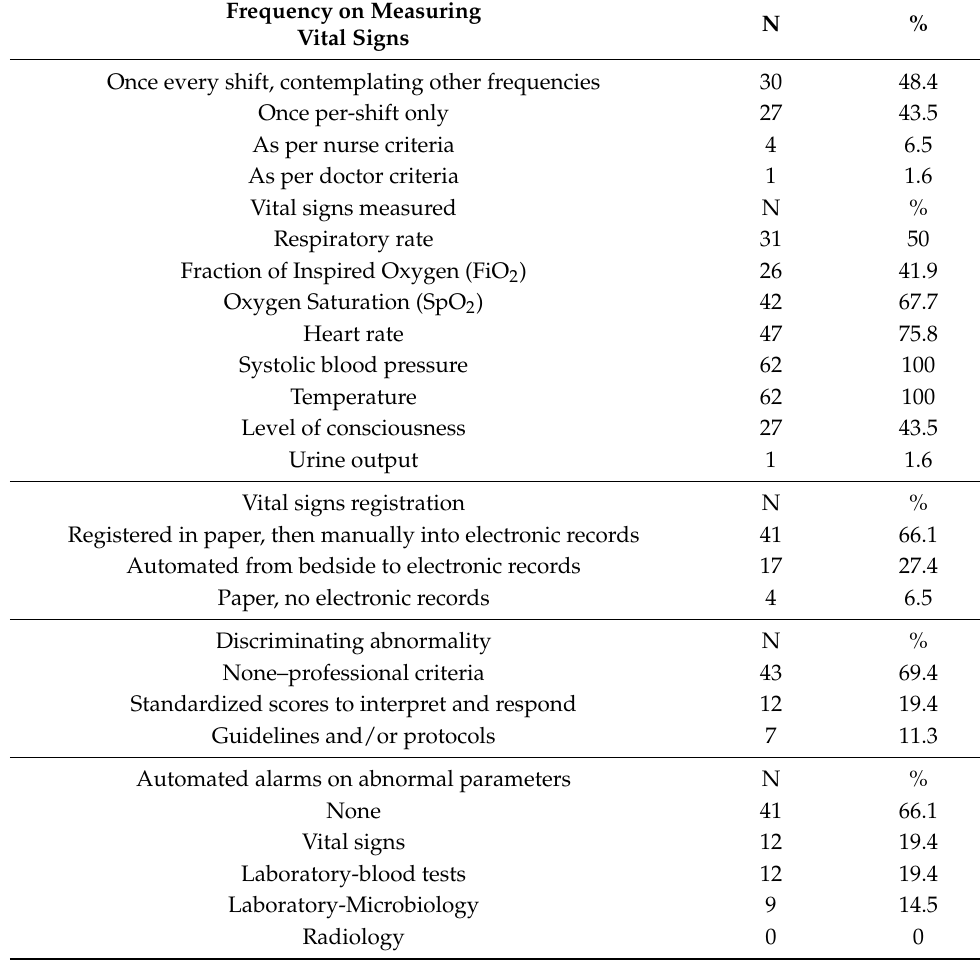
Table 1. Afferent limb: detecting clinical deterioration.